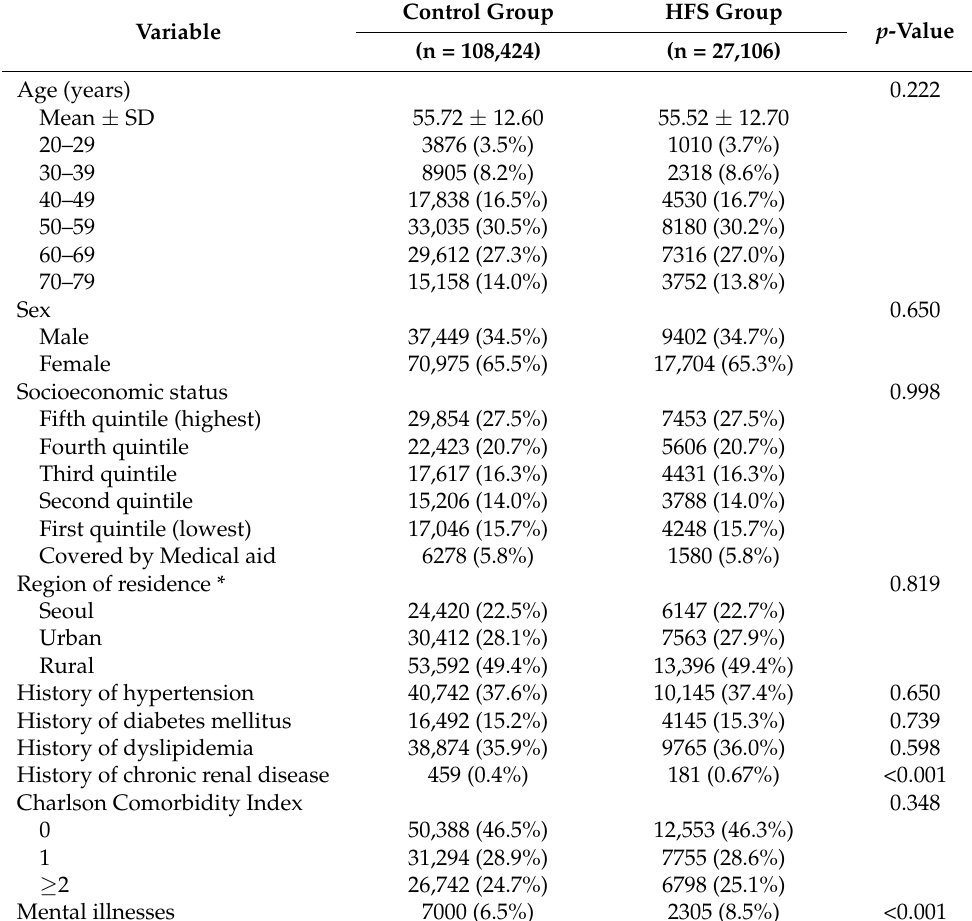
Table 2. Baseline characteristics of the study